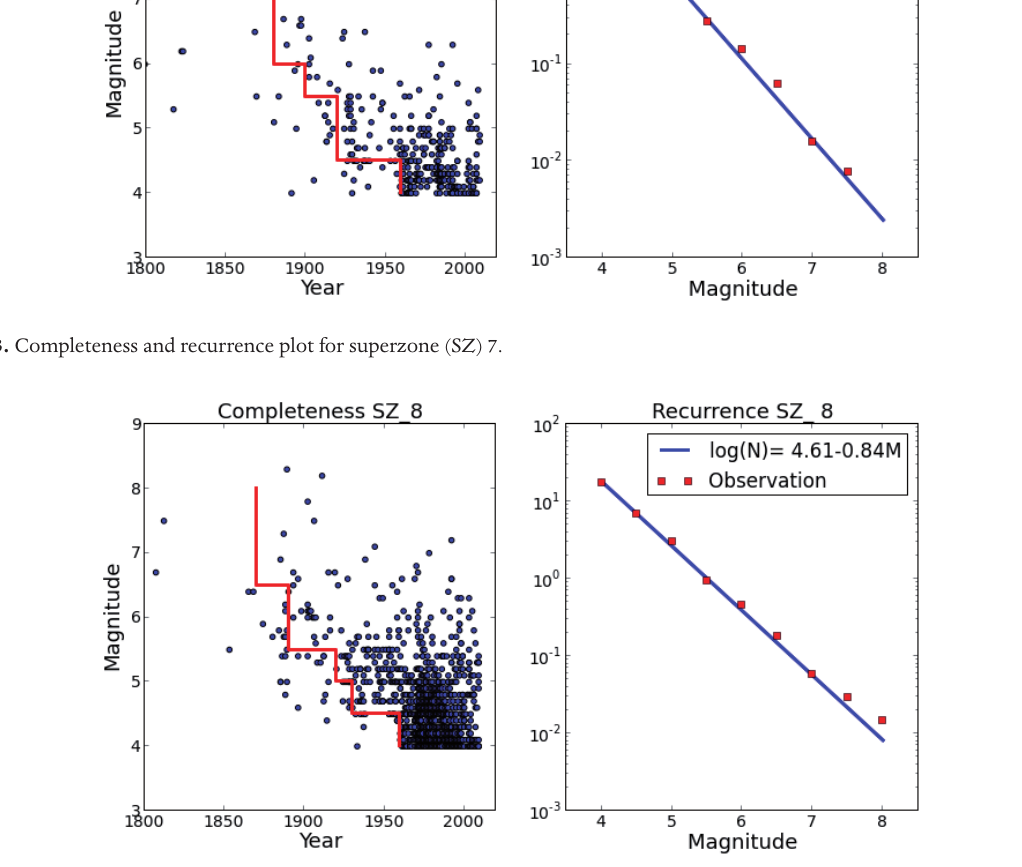
Figure 4. Completeness and recurrence plot for superzone